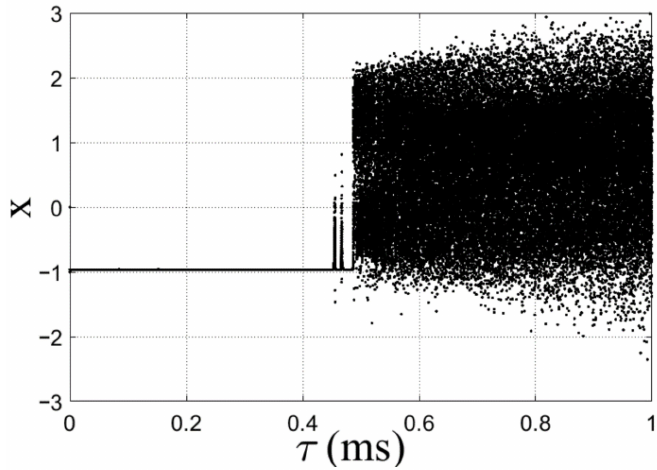
Figure 6. The bifurcation diagram of the system (1) with nonlinearity (3) as a function of time delay τ for system parameters a = 1, b = 2.6, and k =